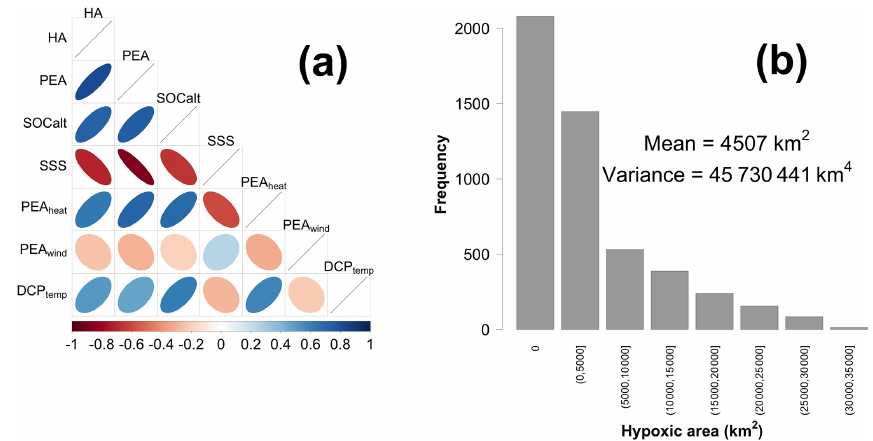
Figure 1. (a) A correlation matrix of the response variable and candidate predictors and (b) the frequency distribution of HA. Data are provided daily from 1 January 2007 to 26 August